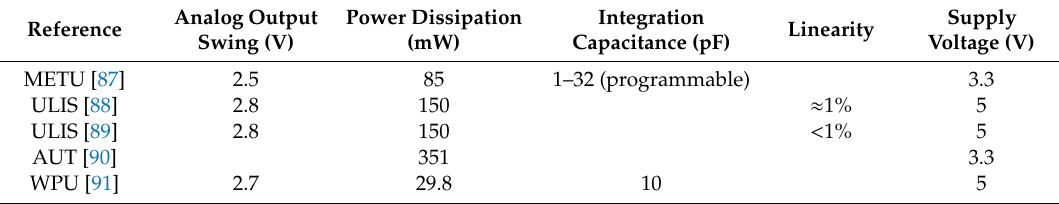
Table 2. Parameters of capacitive transimpedance amplifier (CTIA) read-out circuit in microbolometer infrared focal plane arrays (IRFPAs).